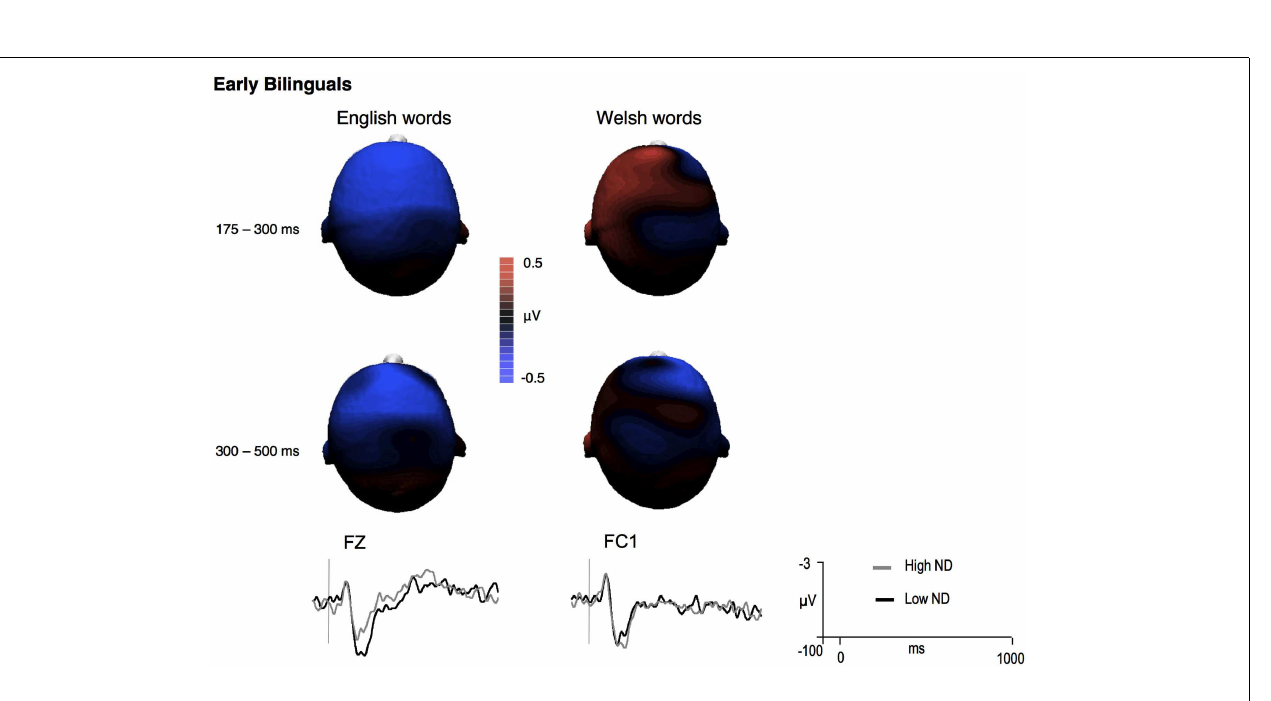
FIGURE 5 | Difference voltage maps representing the cross-language ND effect (high ND – low ND) in early bilinguals and mean grand-averages ERPs at the site where the effect was largest (only for